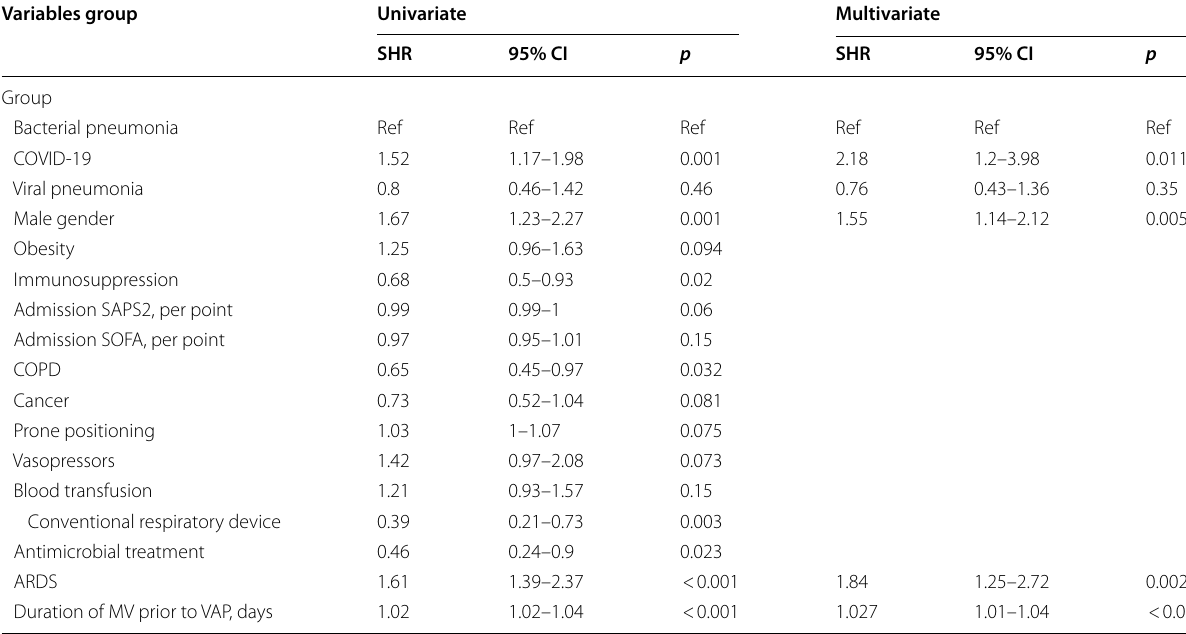
Table 3 Determinants associated with ICU-acquired pneumonia using sub-distribution hazard ratio in univariate and multivariate